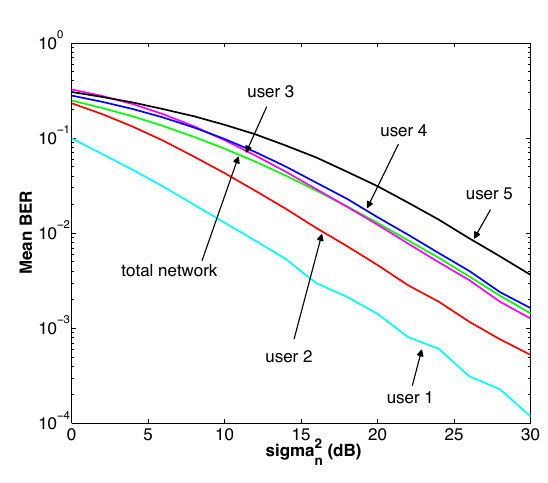
Figure 5. BER Performance of the total network and every user separately (SISO BC). The closer a user is to the basestaion, the better their BER performance.